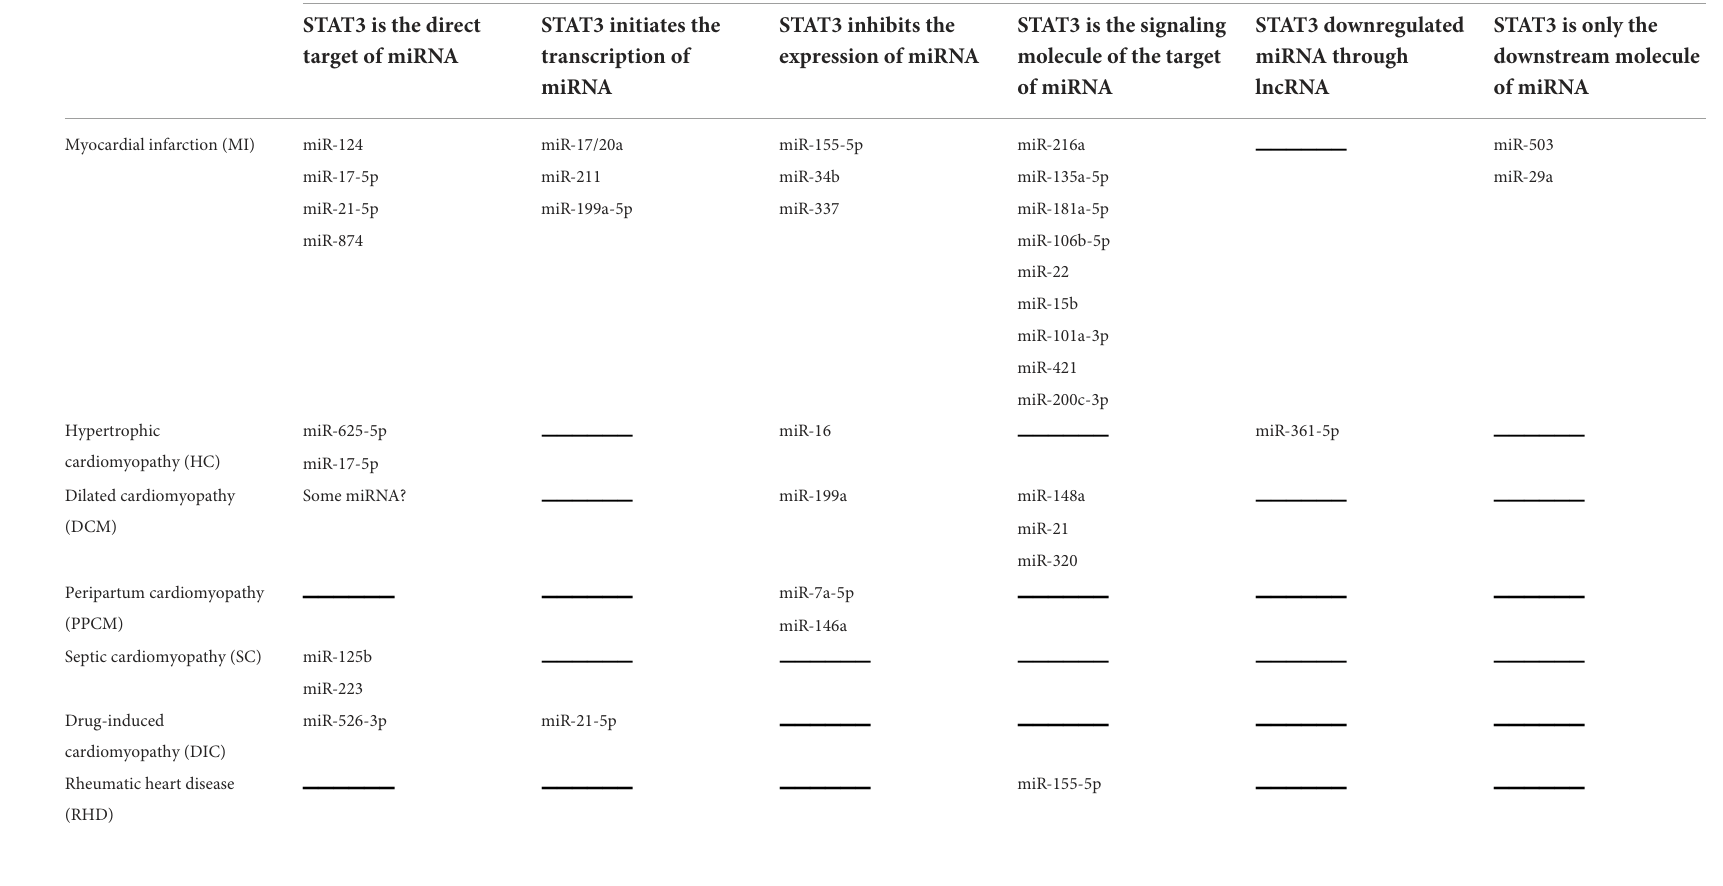
TABLE 1 STAT3-miRNAs circuits in different cardiac diseases and protection. Cardiac